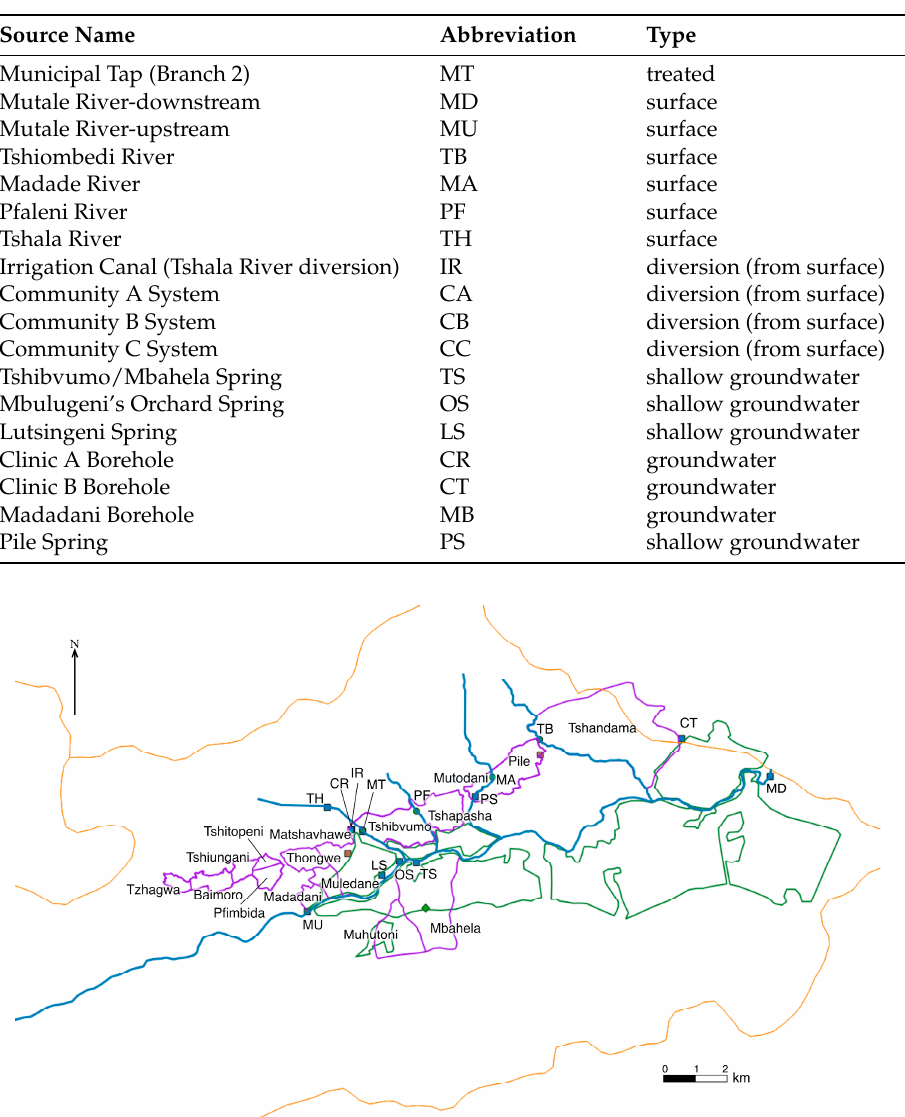
Figure 1. Map of the study area. The communities are all located within the Mutale River watershed. The rivers are indicated in blue, villages outlined in purple, environmental samples in blue squares, tributaries in green circles (which have intermittent flow), watershed boundary in orange. This heavily agricultural area has cultivated areas along both sides of the Mutale River for the vast majority of the region; the area is shown with green outlines. There are two identified brick-processing areas shown in brown rectangles. Unfortunately, some sites are so close that the markers overlap (as with CR and IR). The location of the community supplies (CA, CB, and CC) are not shown to protect the privacy of those villages. See supplemental information for Google Earth files.